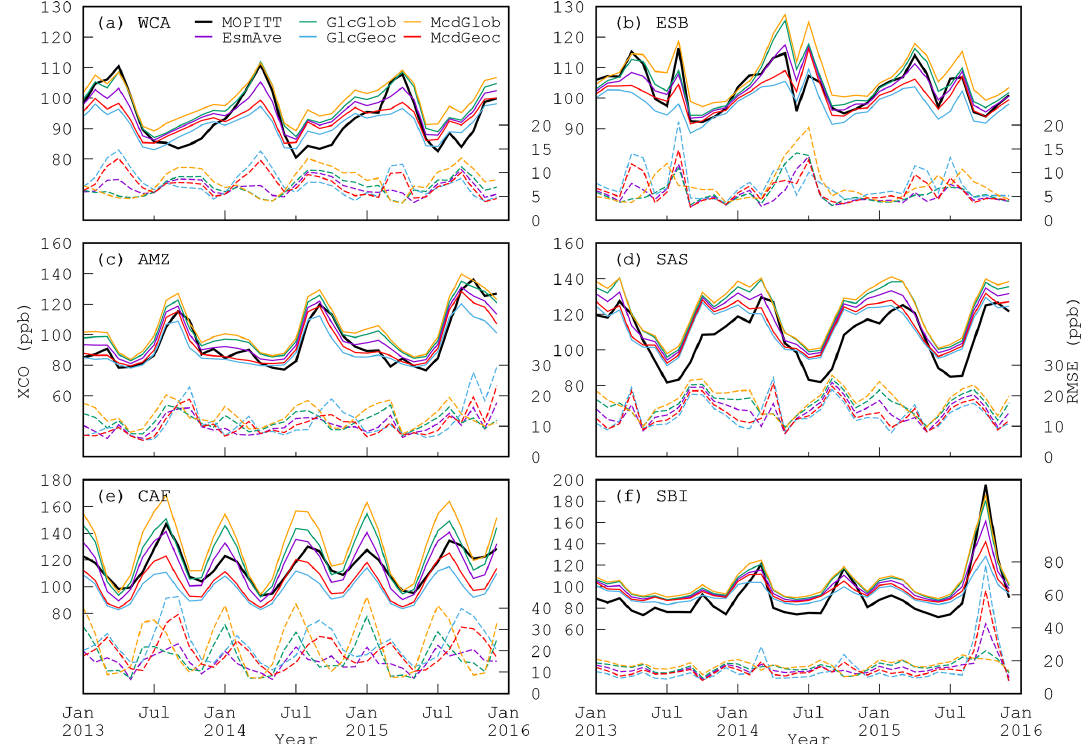
Figure 7. Monthly mean XCO variations (ppb; solid) and RMSE (ppb; dashed) between observed and simulated fields over the six